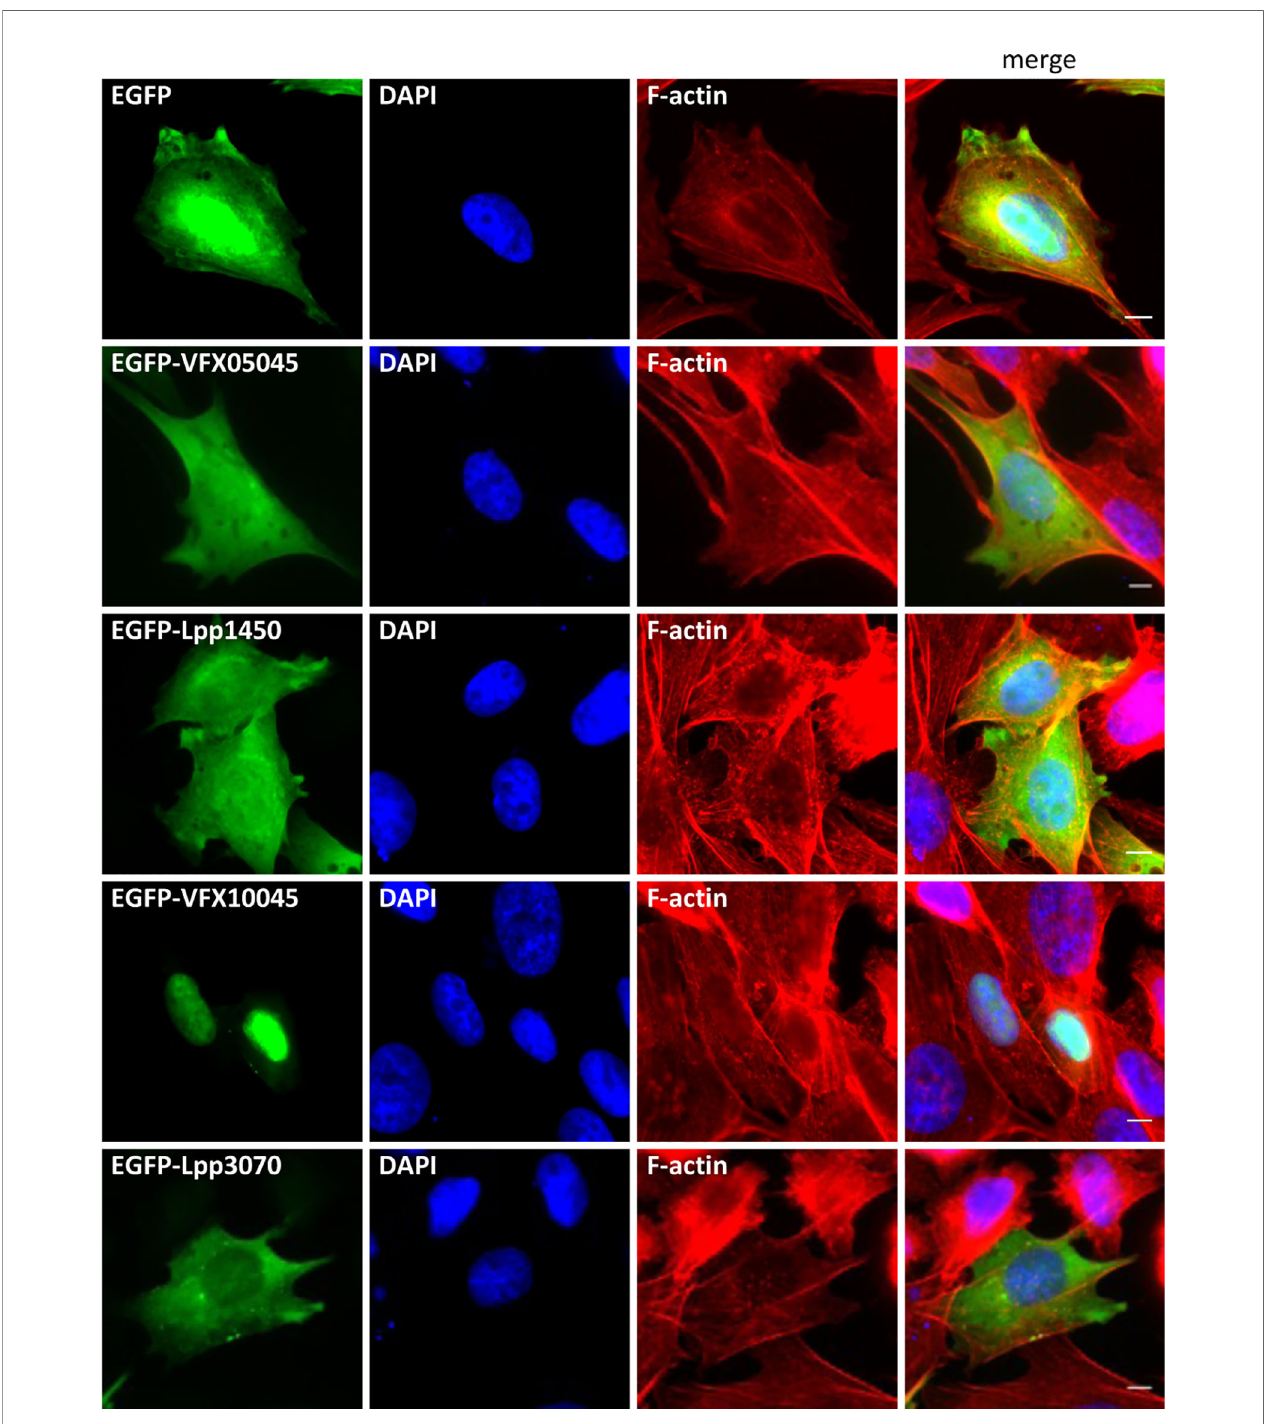
FIGURE 3 | Subcellular localization of L. pneumophila Icm/Dot substrates orthologs VFX05045, Lpp1450, VFX10045 and Lpp3070 in CHO cells. Plasmids encoding EGFP fusions to VFX05045, VFX10045, Lpp1450 and Lpp3070 were used to transiently transfect CHO mammalian cells. Cells were fi xed with 4% PFA (w/v), permeabilized with 0.1% Triton X (v/v) and labeled with Phalloidin-AlexaFluor-555 and DAPI. Scale bar, 5